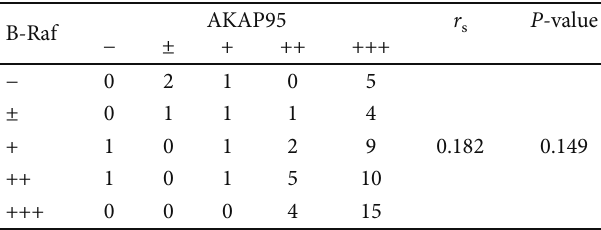
Table 5: The relationship between AKAP95 and B-Raf protein expression in colon cancer